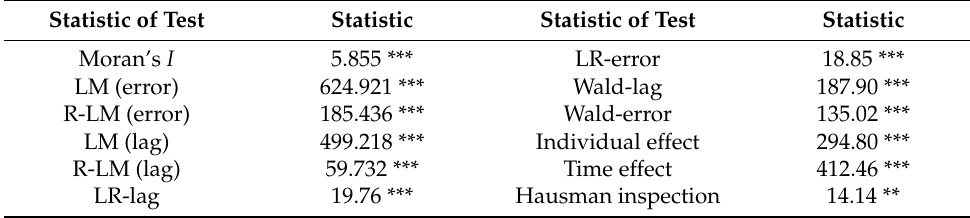
Table 1. Comparison of spatial panel model test